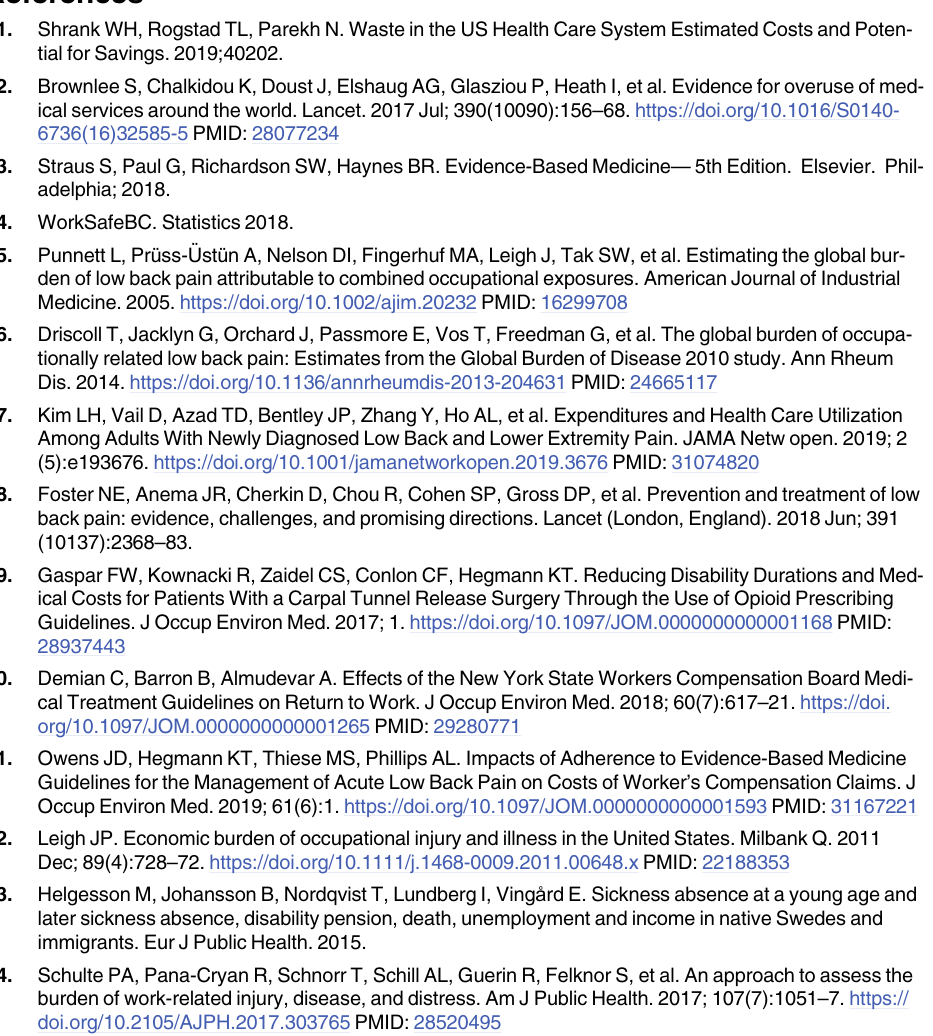
S7 Table. Comparisons between select recommendation statements of the ACOEM, Amer- ican College of Physicians (ACP) and United Kingdoms’ National Institute of Health and Care Excellence (NICE) guidelines for acute low back